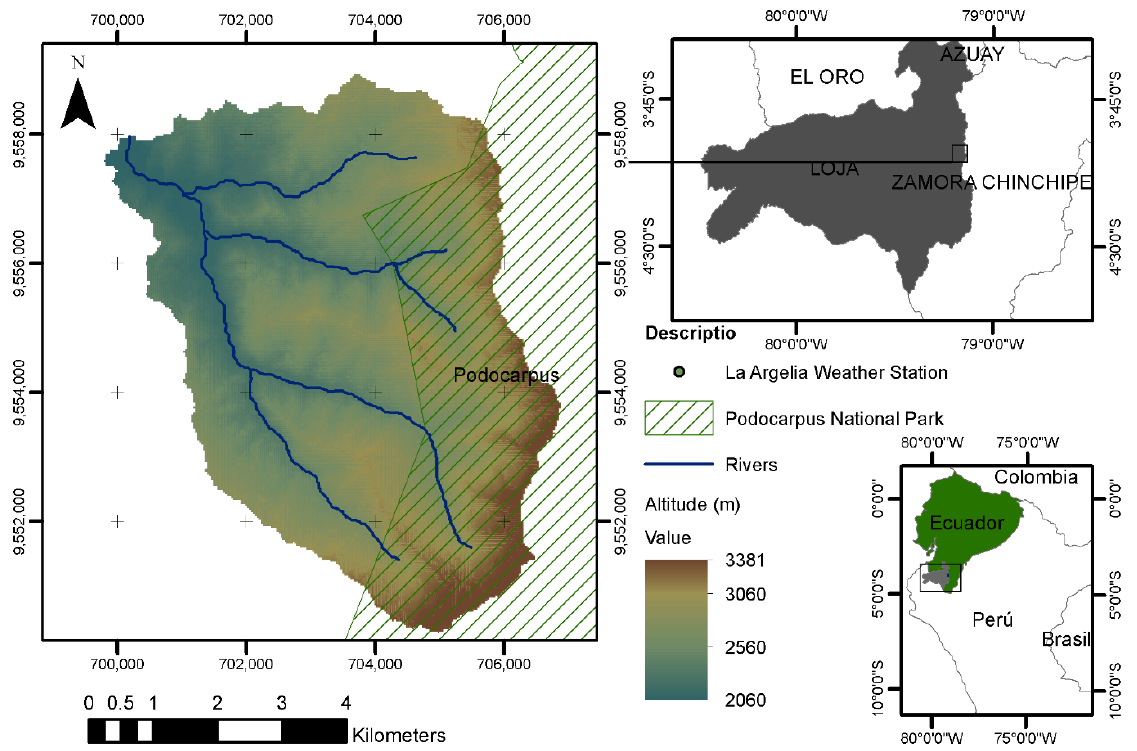
Figure 1. Location of the Zamora Huayco, an Andean basin in southern Ecuador.